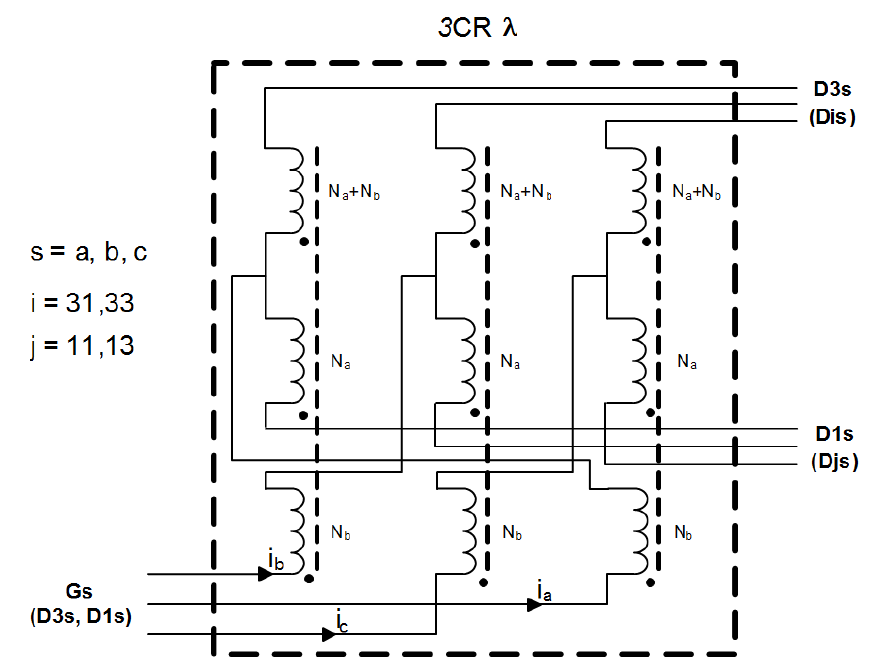
Figure 1. The coupled reactor unit 3CRλ—a coil configuration and notation code.